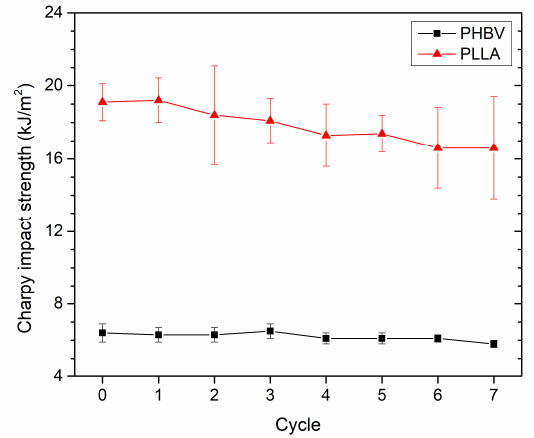
Figure 11. PLLA and PHBV flexural properties as a function of recycled cycle: ( a ) flexural strength; ( b ) flexural modulus.